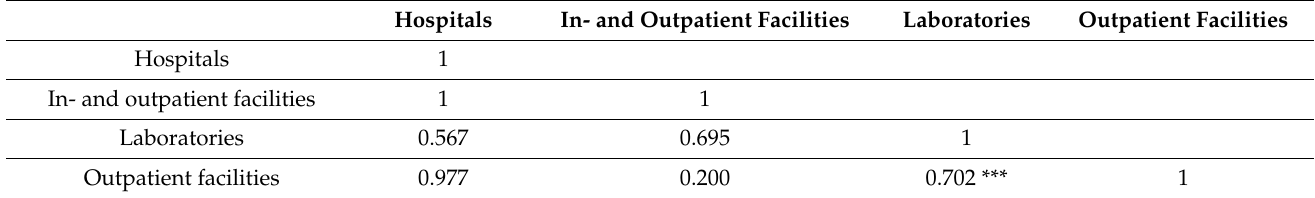
Table 5. Correlation matrix, Europe.